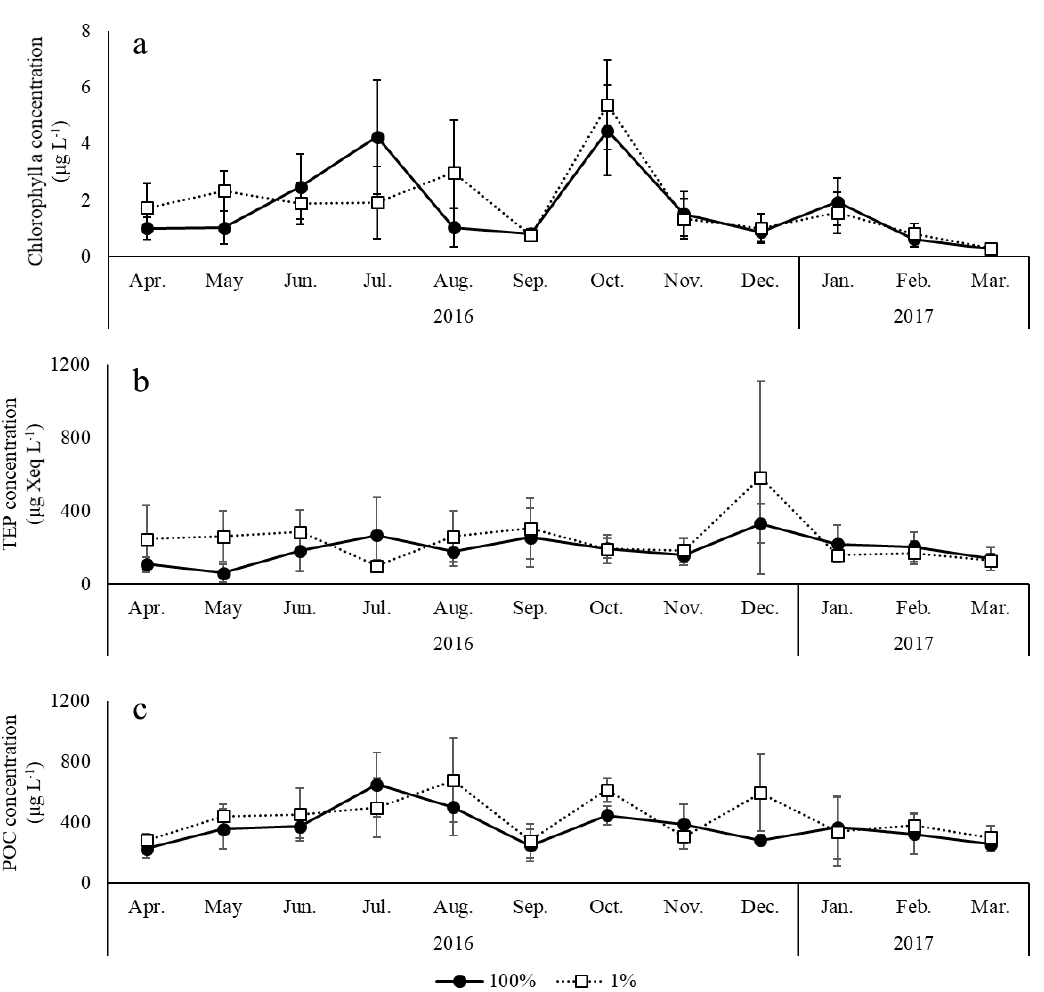
Figure 2. Monthly variations in the ( a ) transparent exopolymer particles (TEP) ( µ g Xeq L − 1 ), ( b ) chlorophyll a ( µ g L − 1 ) and ( c ) particulate organic carbon (POC) ( µ g L − 1 ) concentrations at the 100% and 1% light depths averaged from 7 different stations in Jaran Bay.